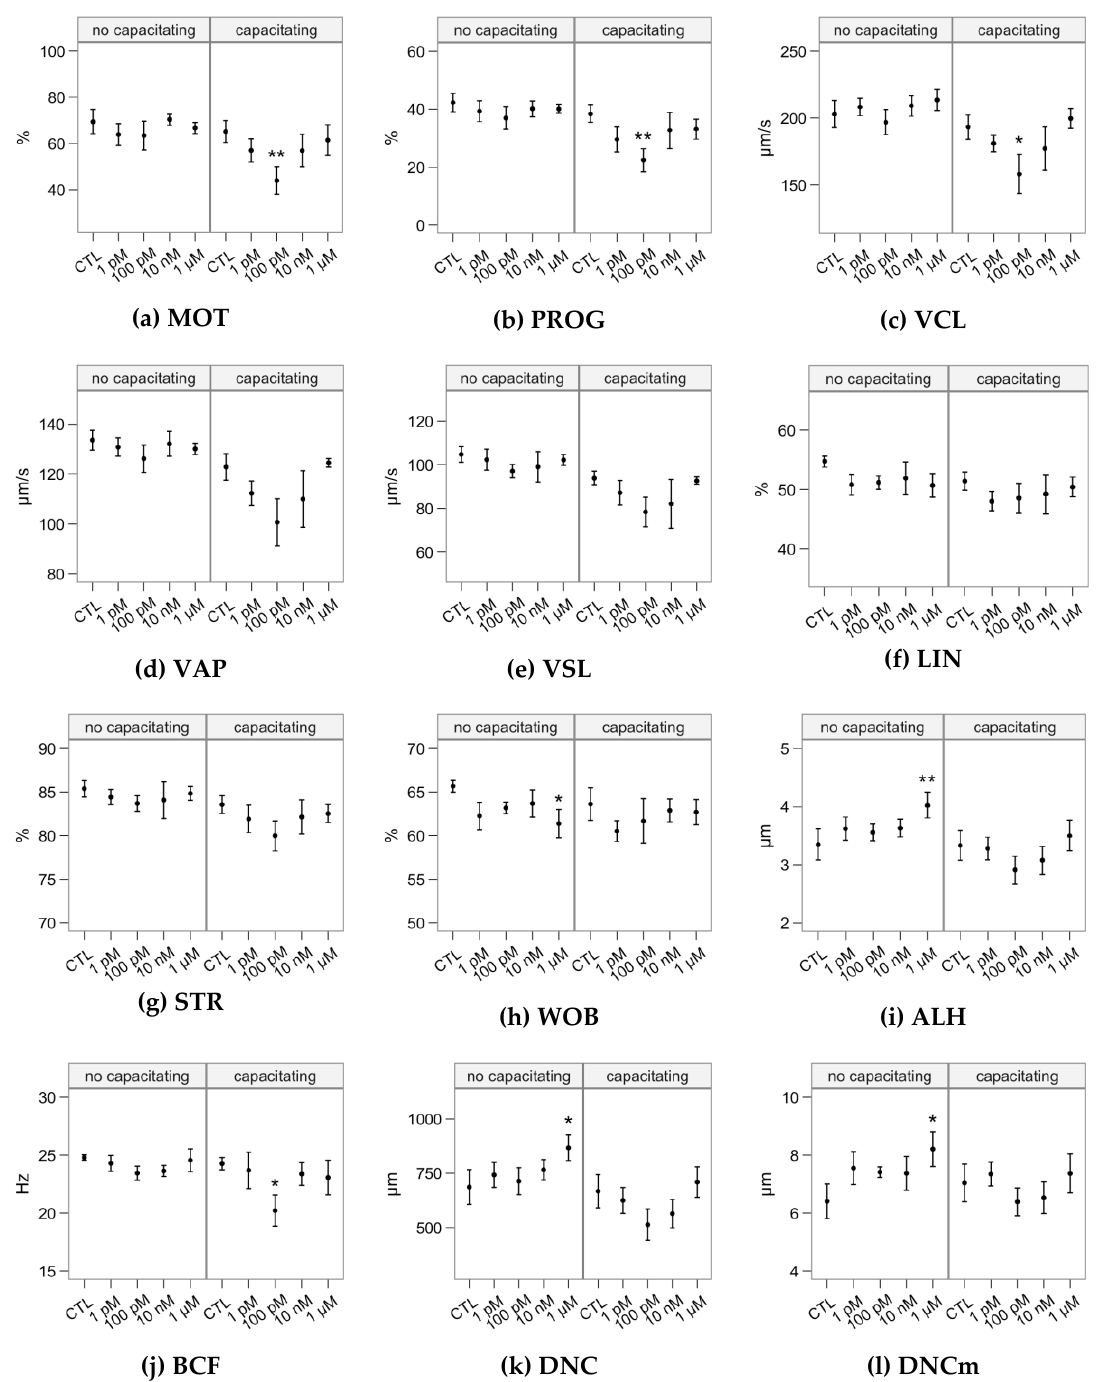
Figure 4. Effects of incubating bull spermatozoa with different melatonin concentrations on motility parameters (CASA analysis; Control, no melatonin, as reference). Plots show mean ± SEM for each concentration in the two in the absence (no capacitating) or presence (capacitating) of heparin (variable names expanded in Figure 1). Asterisks label melatonin effects significantly different from the Control (* p < 0.05, ** p < 0.01).